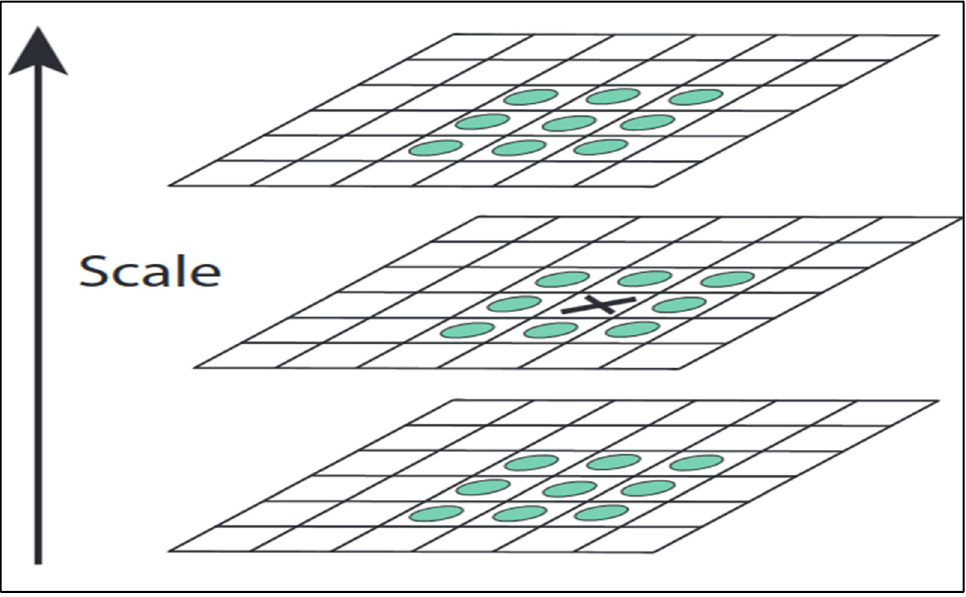
Figure 12. Detection of local minima and maxima.